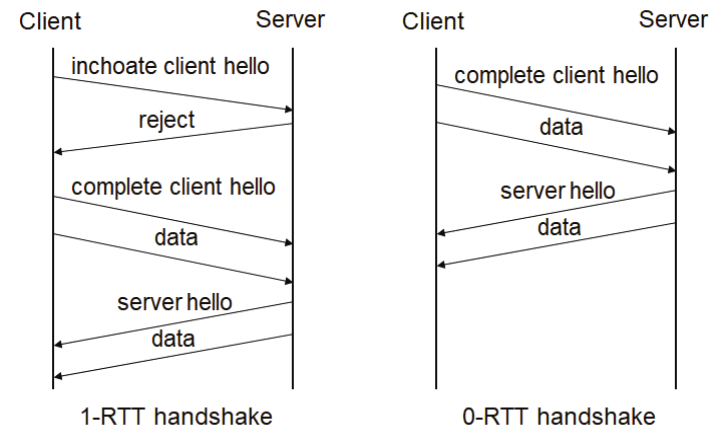
Figure 3. Connection establishment in the QUIC